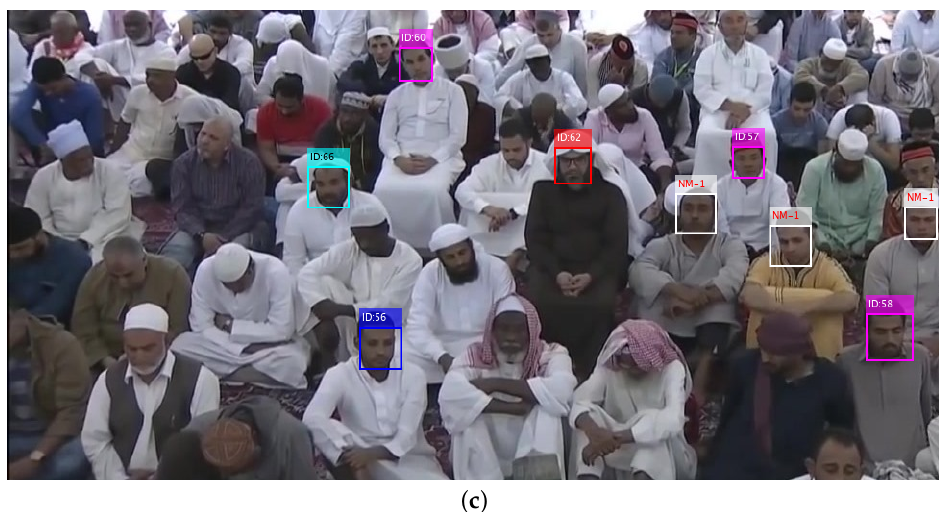
Figure 7. Tracking of subjects ID-47, 51 and 53 in three different camera views. ( a ) Camera view 1; ( b ) Camera view 2; ( c ) Camera view 3.